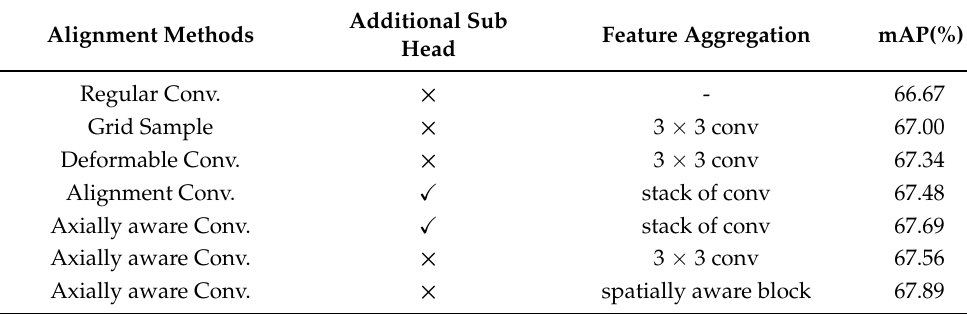
Table 3. Performance comparison of different feature alignment